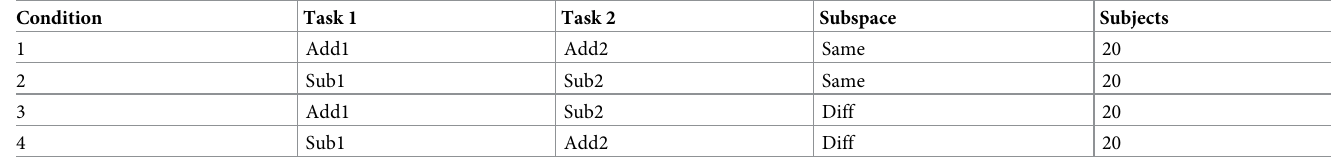
Table 1. Subjects and